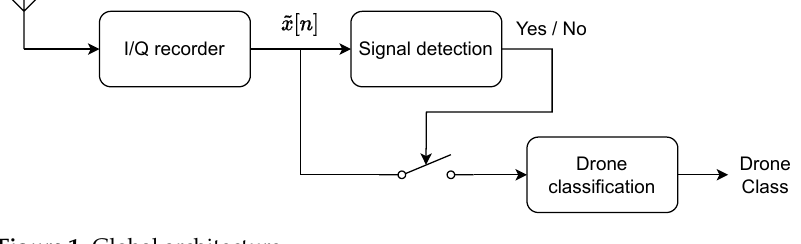
Figure 1. Global